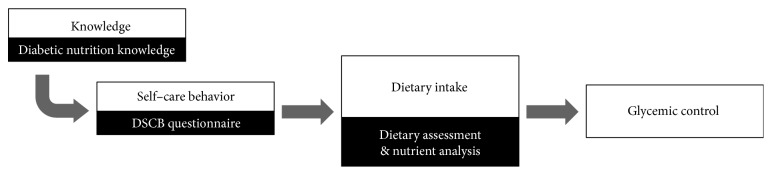
Objective diagram of this study.